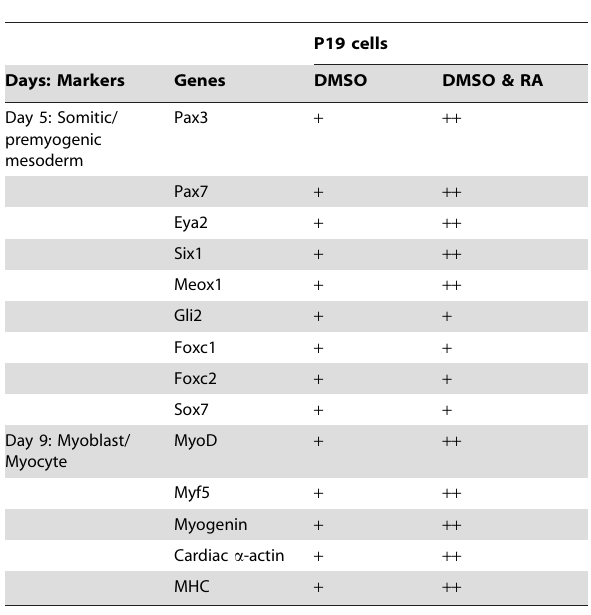
Table 1. Summary of changes in gene expression in P19 cells treated with DMSO with or without 3 nM RA, compared to untreated cells.